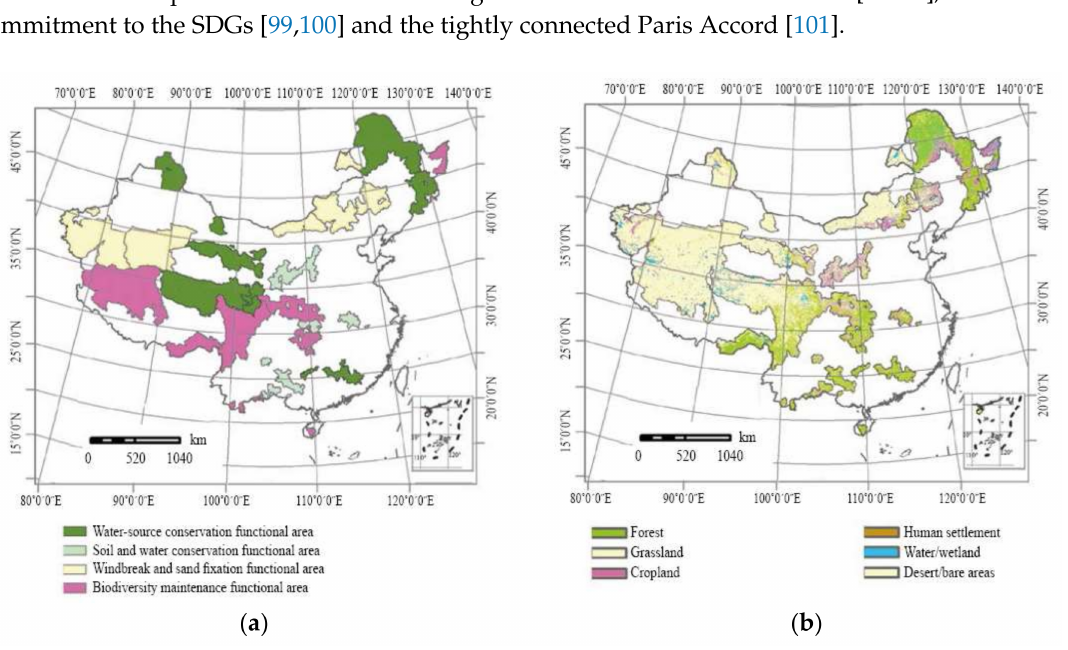
Figure 4. China’s strategy of National Key Ecological Function Areas, according to ( a ) functional areas and ( b ) major ecosystems [91]. Used with